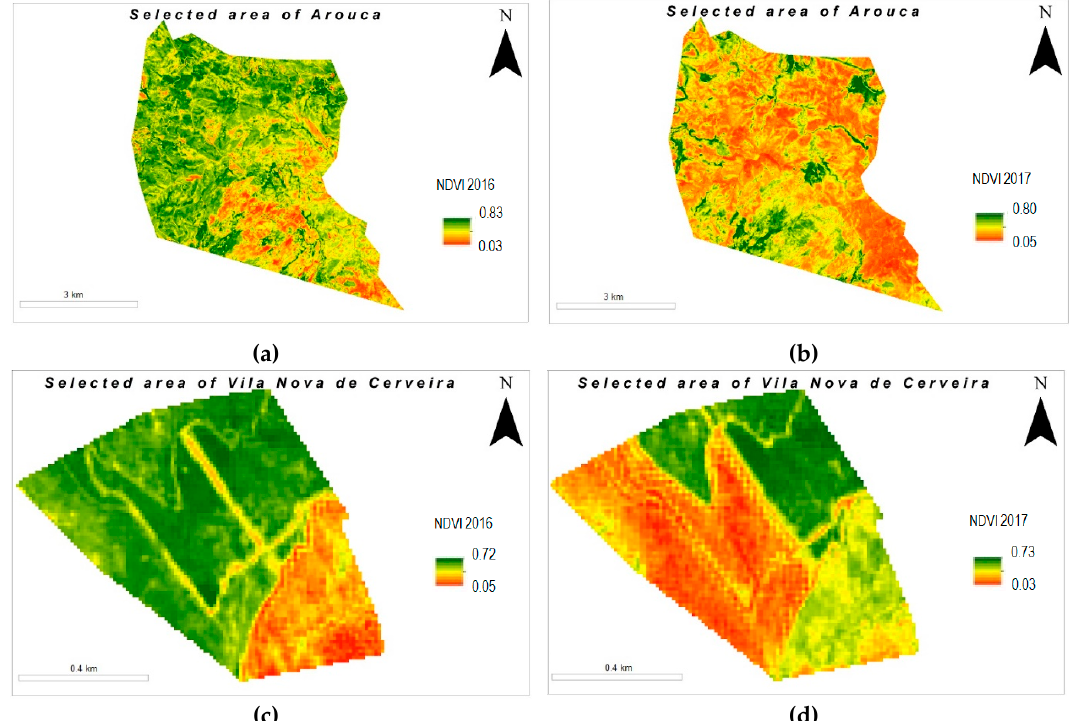
Figure 6. NDVI maps of the specifically selected areas for: ( a ) prefire and ( b ) postfire in Arouca; and ( c ) prefire and ( d ) postfire in V. N. Cerveira, derived from Sentinel 2A data (adapted from [44]).